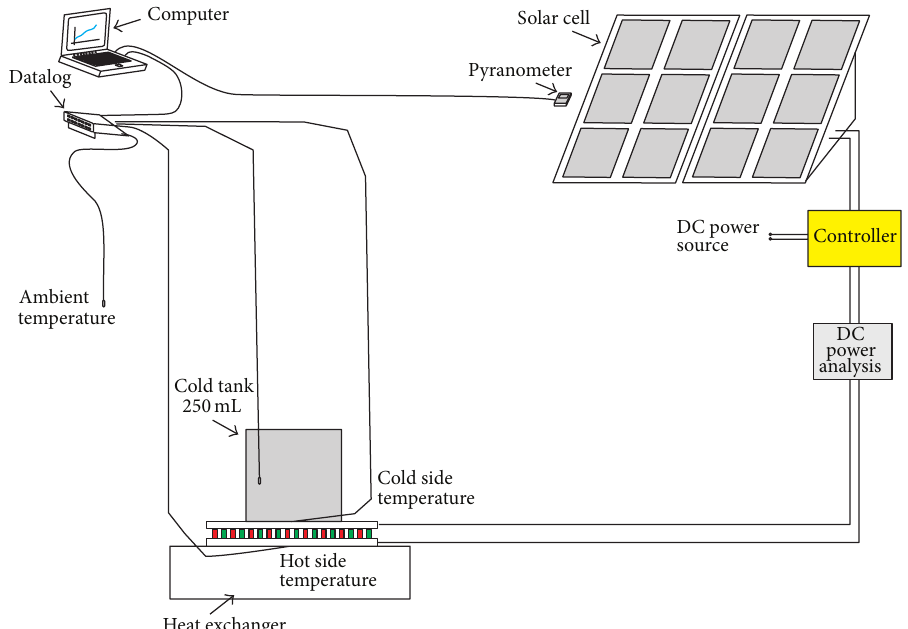
Figure 2: Experimental setup and measurement of solar thermoelectric chiller.